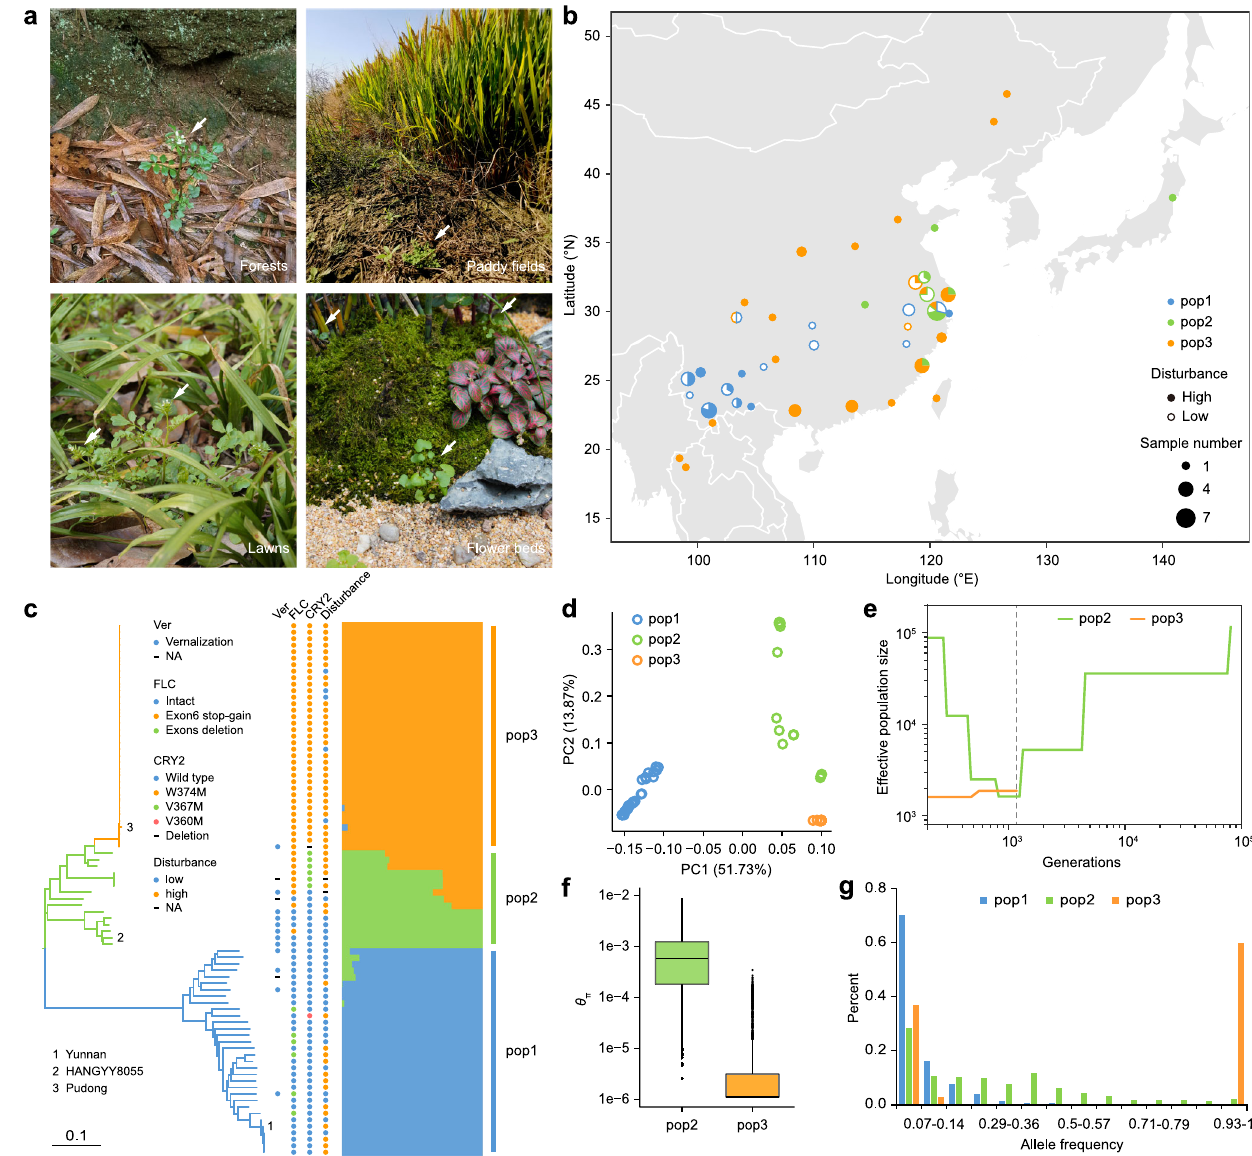
Fig. 1 | The population structure of C. occulta in East Asia. a Representative C. occulta plants growing in forests, paddy fi elds, lawns, and fl ower beds. The white arrows point to wild C. occulta plants. b Distribution of the C. occulta accessions used in this study. The area of each pi represents the sample size in each site, and the colors indicate C. occulta subgroups. The fi lled circles and the open circles represent the high-disturbance and low-disturbance habitats, respectively. c A neighbor-joining tree of 82 C. occulta accessions constructed using whole-genome SNP data. Branch colors denote subgroups. Three representative accessions, Yunnan, HANGYY8055, and Pudong, are marked with 1, 2, and 3, respectively. The colors of the dots to the right of the tree indicate vernalization requirement (Ver), haplotypes of FLC and CRY2 , and degree of habitat disturbance of each accession. Shortblacklines,datanotavailable.TheADMIXTUREresultsat k =3,whichhadthe lowest cross-validation error, are shown on the right. Subgroups (pop1, pop2, and